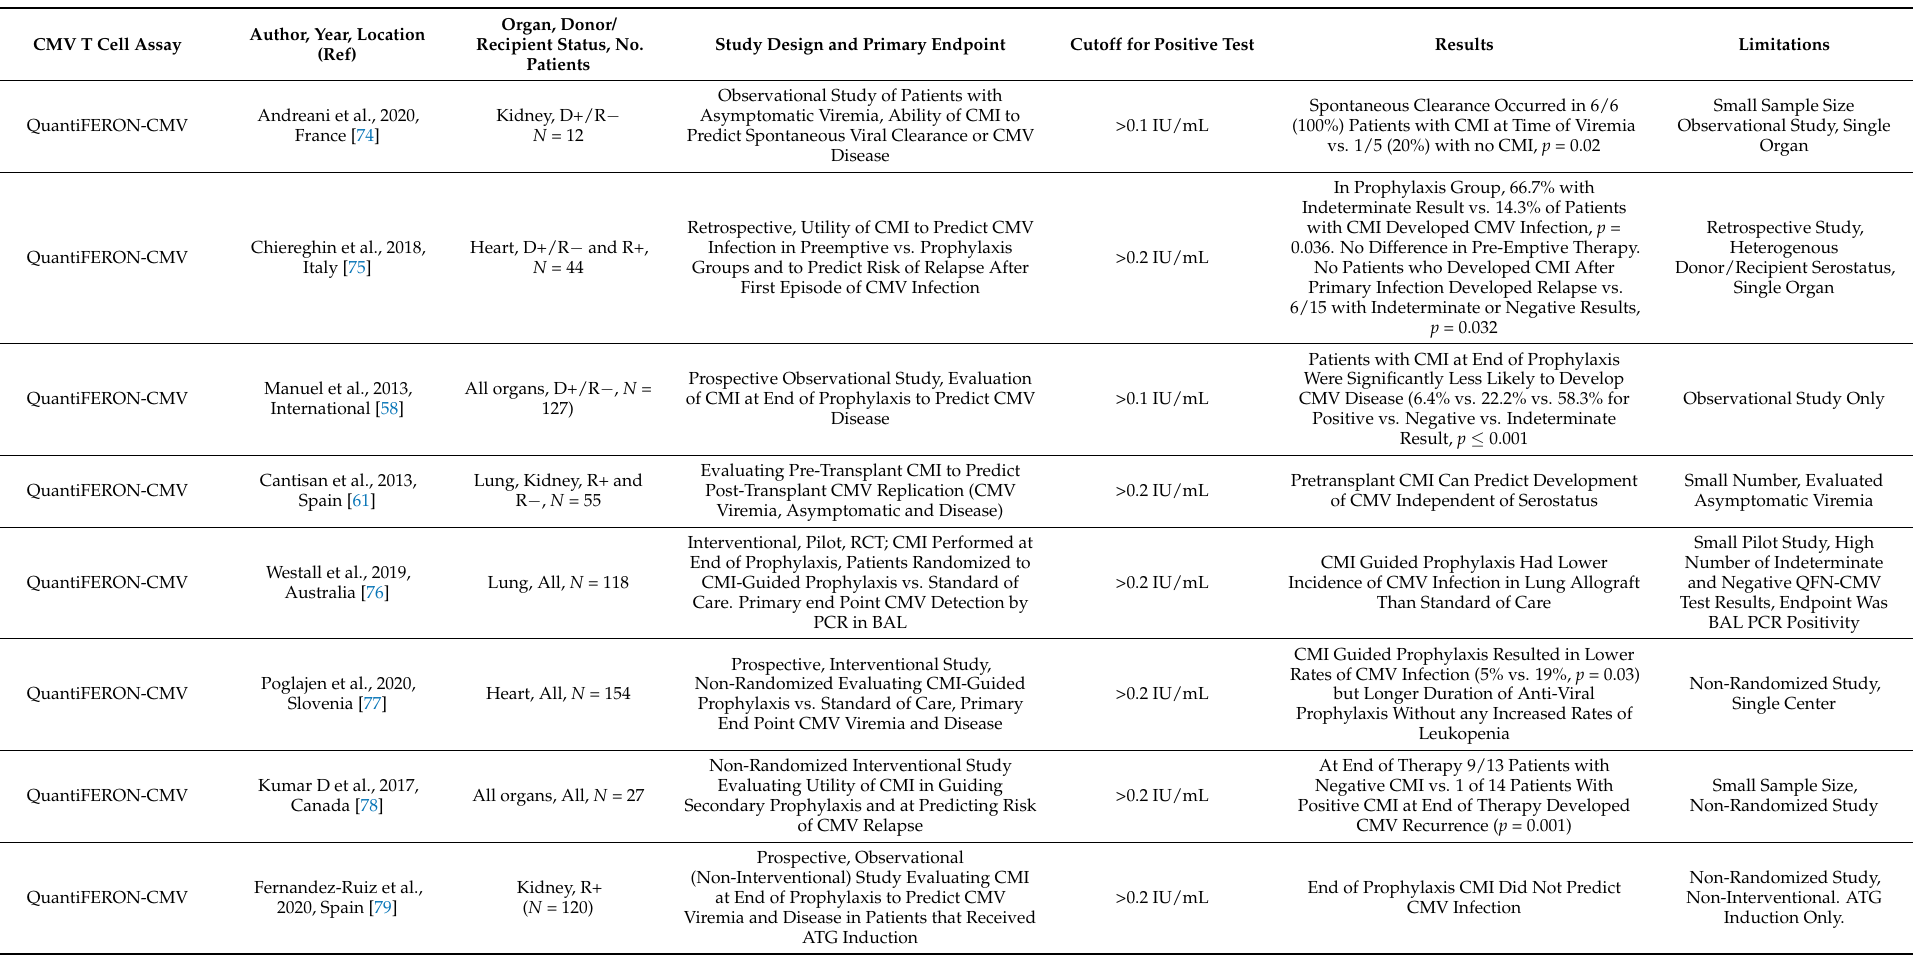
Table 2. Summary of the recent relevant interventional and observational studies evaluating CMV-specific cell-mediated immunity in solid organ transplant recipients. CMV T Cell